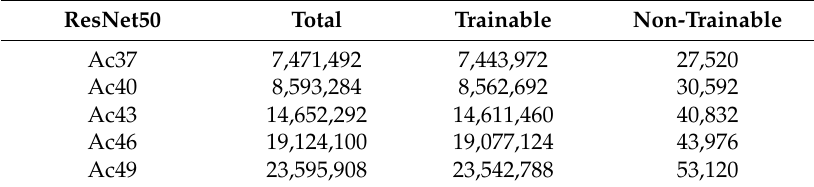
Table 2. The number of parameters in ResNet50 sub-networks.